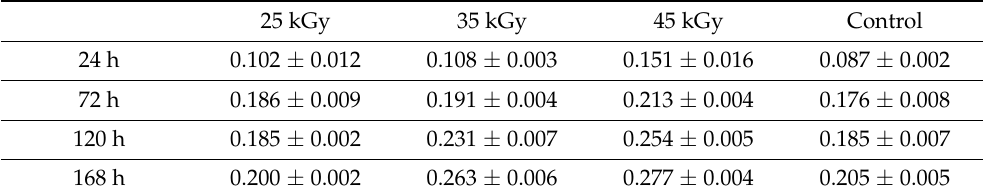
Figure 3. Presto Blue TM cytocompatibility assessment with hDPSCs. Results presented as mean ± SE. Results’ significance is presented through the symbol (*), according to the p value, with one, two, three or four symbols, corresponding to 0.01 < p ≤ 0.05; 0.001 < p ≤ 0.01; 0.0001 < p ≤ 0.001; and p ≤ 0.0001, respectively. Table 1. Presto Blue TM cytocompatibility assessment with hDPSCs. Results presented as mean ± SE.